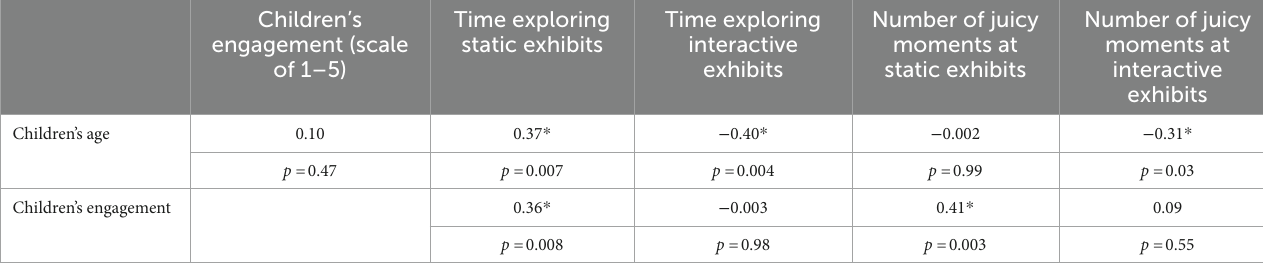
TABLE 1 Correlations among children’s engagement, age, time spent exploring, and juicy